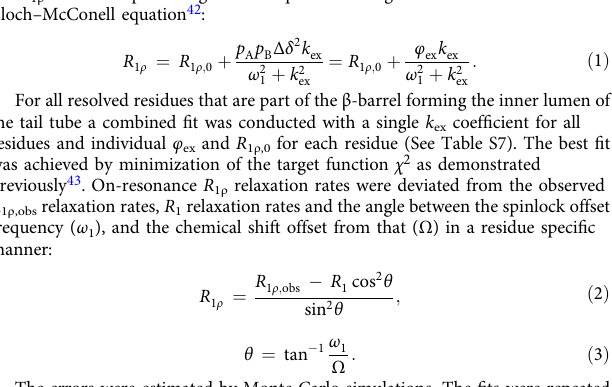
for each — in the 2D hNH spectra distinguishable — amide nitrogen and various spinlock strength-dependent R 1 ρ relaxation rates. For relaxation dispersion analysis the R 1 ρ values are plotted against the spinlock strength and fi tted to a two-site Bloch – McConell equation 42 :